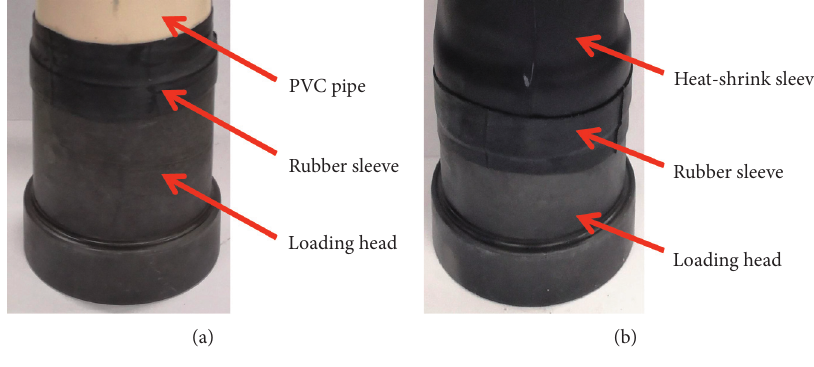
Figure 2: Sealing detail. (a) PS. (b)